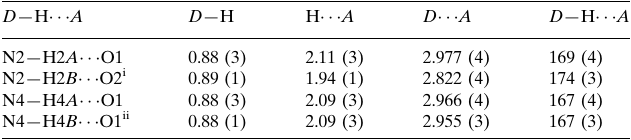
Hydrogen-bond geometry (A˚ , (cid:2)